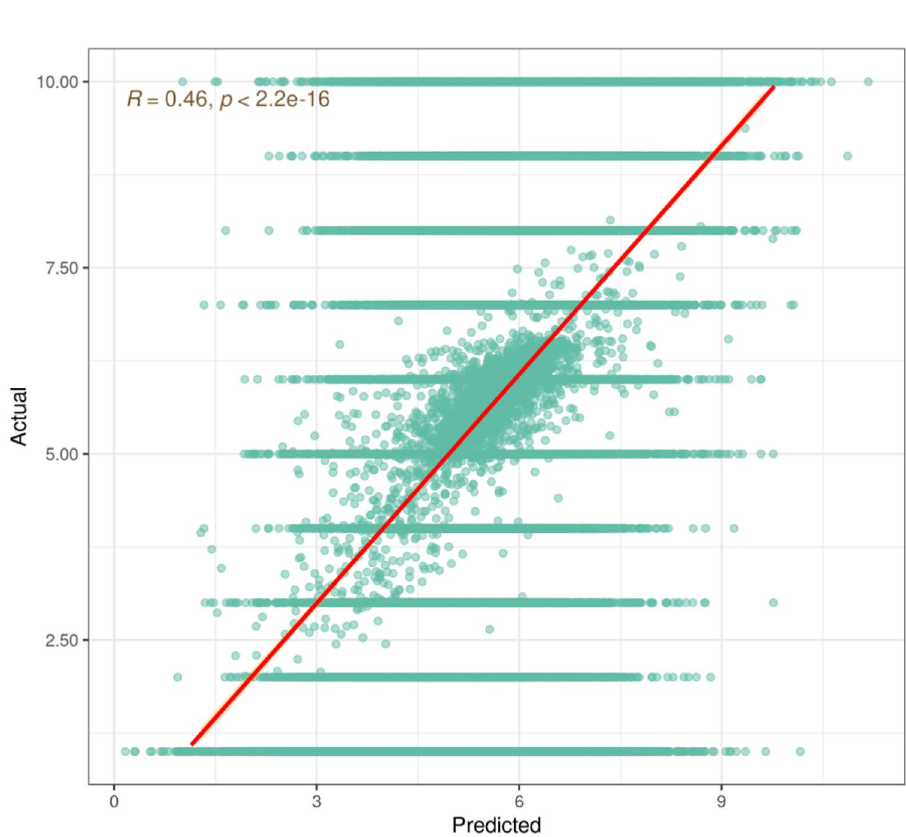
Figure 2. The model’s predicted versus participants’ actual attitudes about inequality in the unseen